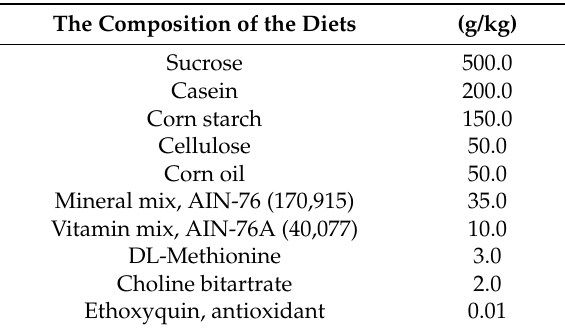
Table 1. Composition of the